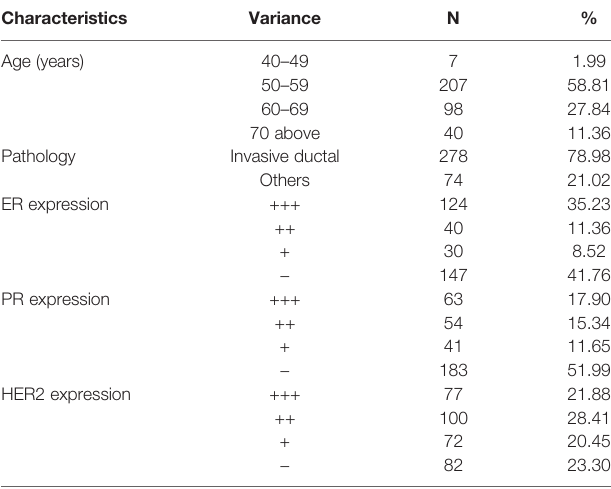
TABLE 1 | Patients ’ characteristics.